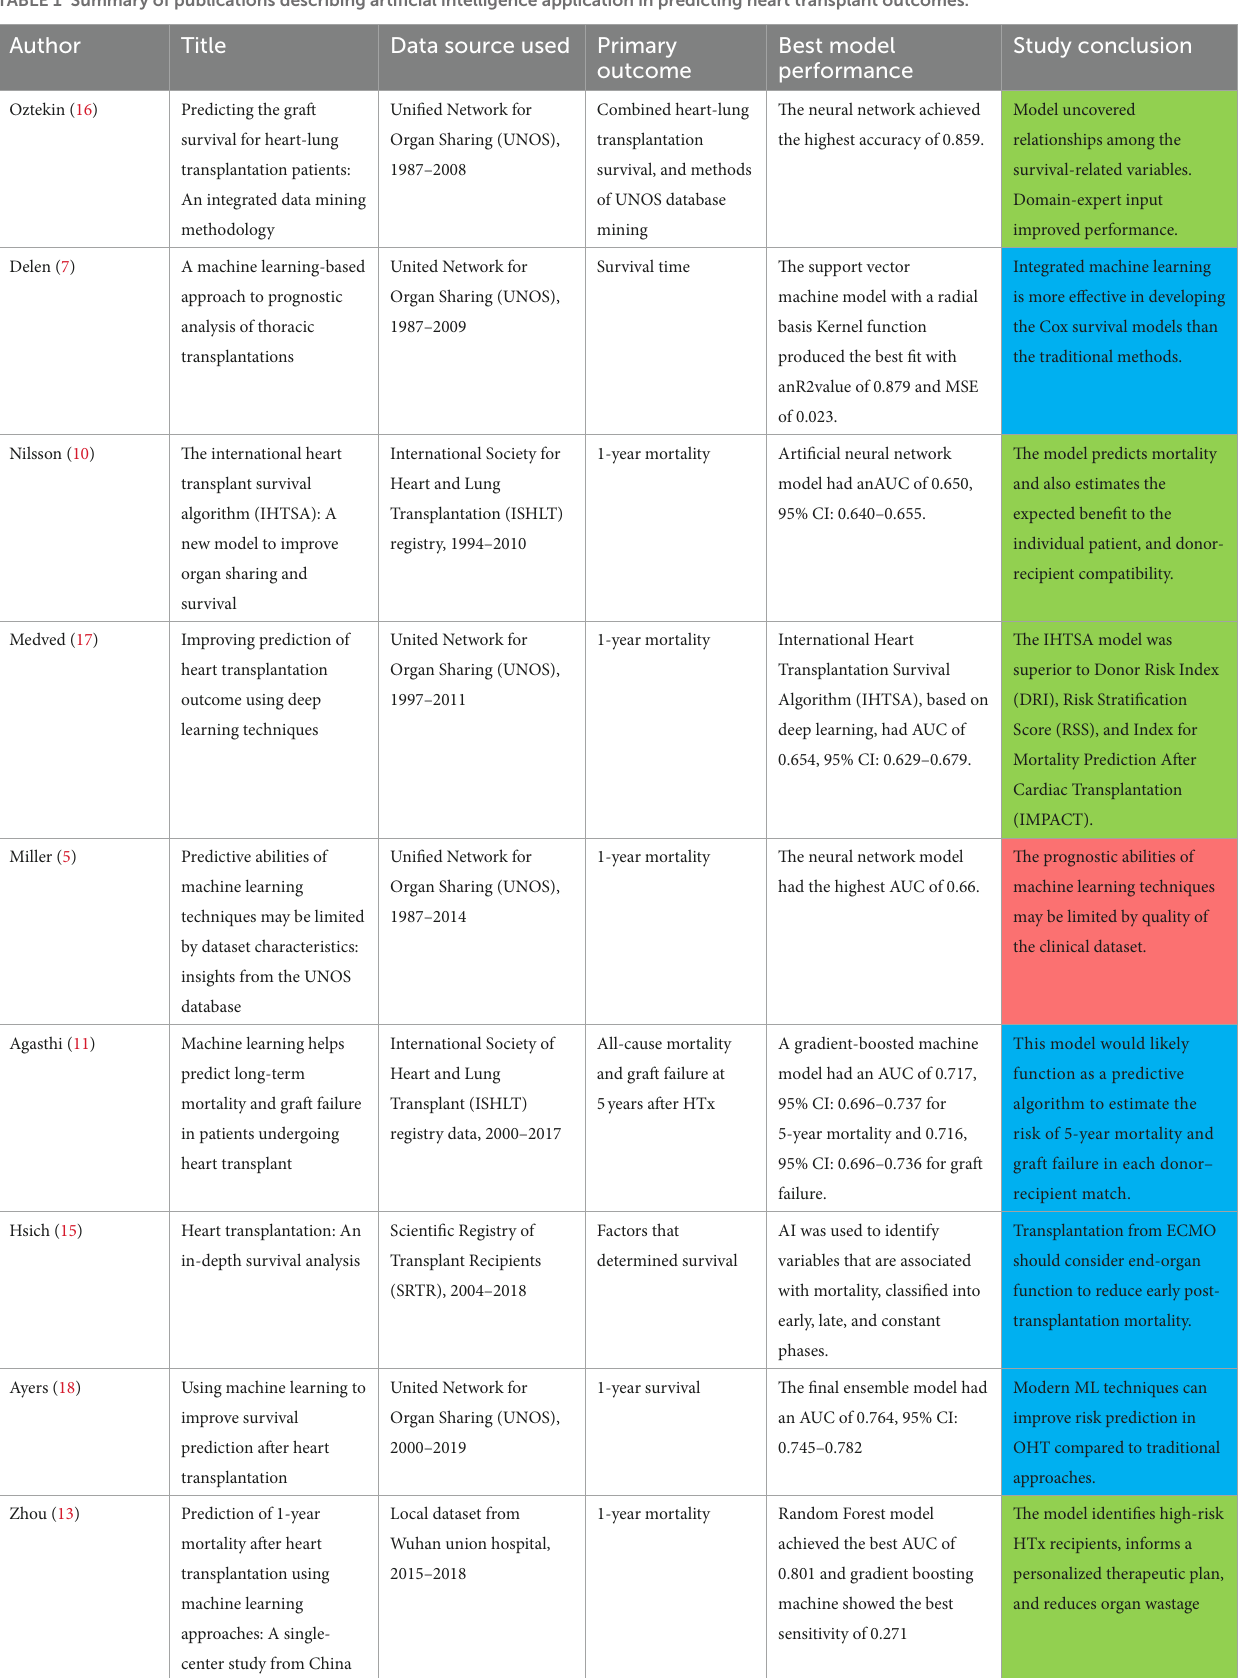
TABLE 1 Summary of publications describing artificial intelligence application in predicting heart transplant